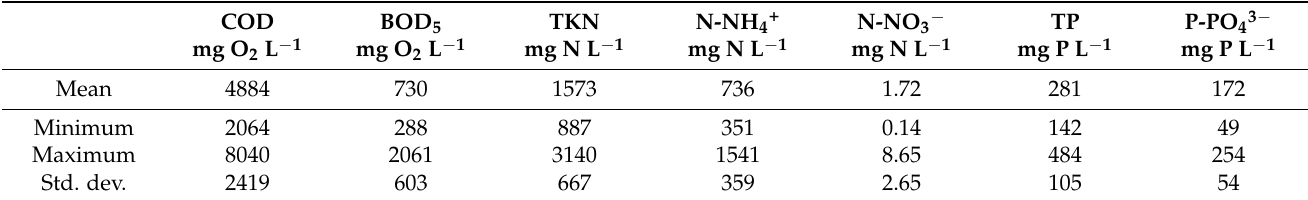
Table 3. The characteristics of rejected water from ATAD process (n = 10), WWTP 3.